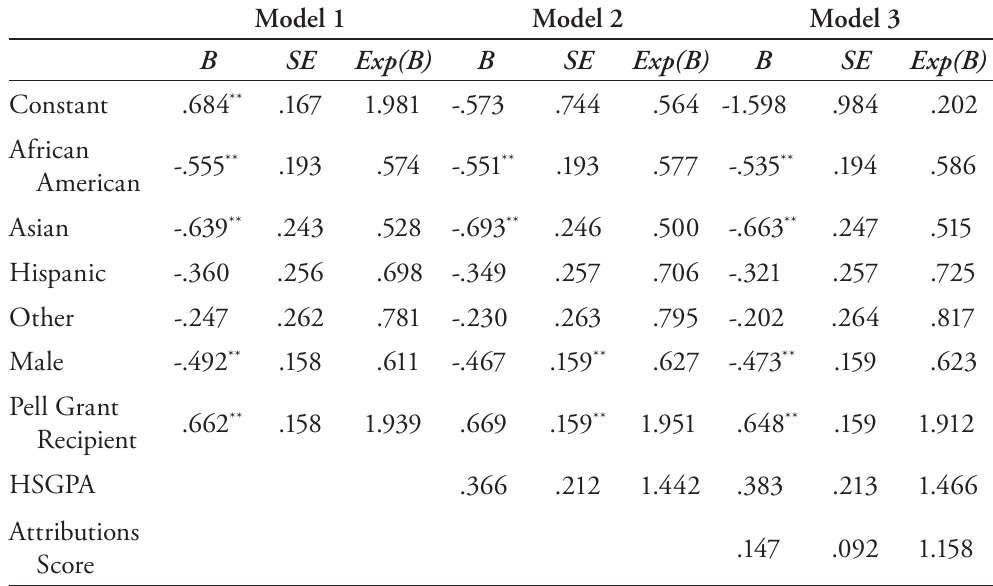
Table 7. Summary of the Hierarchical Logistic Regression Predicting Five- Year Degree